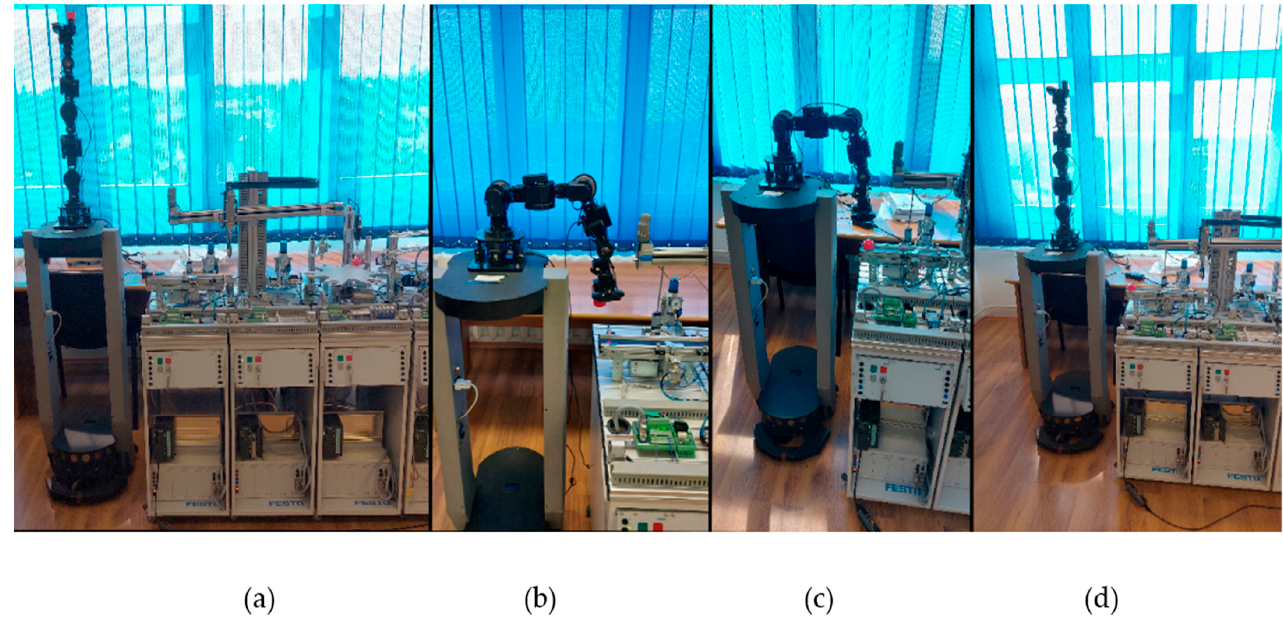
Figure 14. Real time control of the CAS for placing the workpieces with the following order: ( a ) parking position ( b ) scanning position ( c ) placing the object ( d ) RM returning to the home position with the object placed on the workstation.